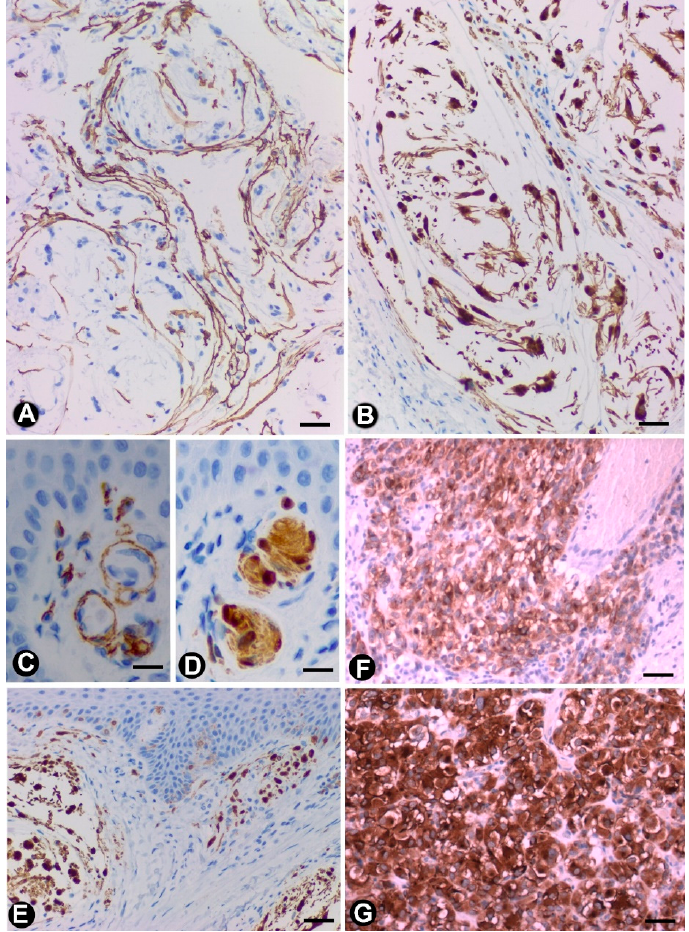
Figure 9. TCs/CD34+SCs and S-100+ cells in nerve myxomas ( A – E ), and CD34 and c-kit